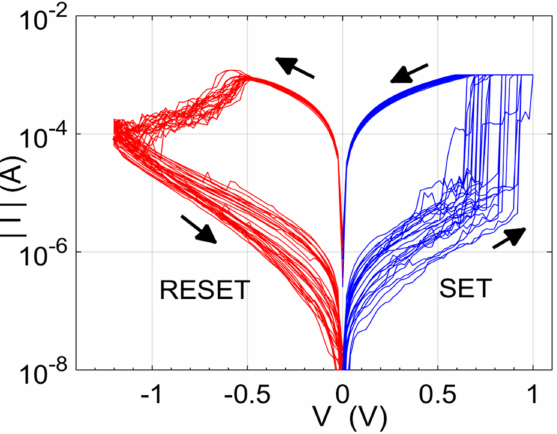
Figure 3. DC resistive switching behavior during successive SET and RESET